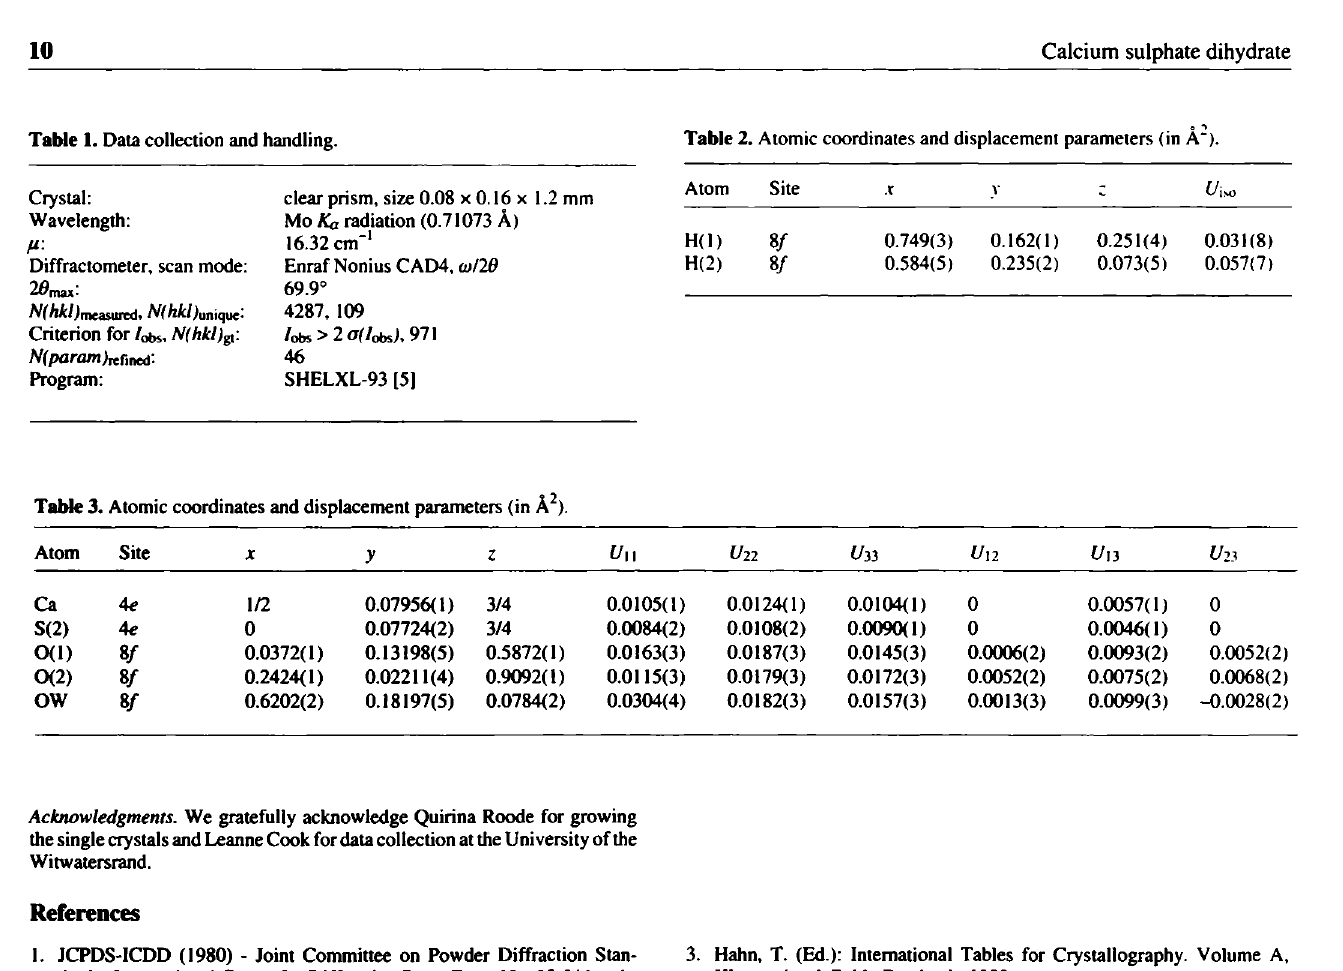
Table 1. Data collection and handling. Table 2. Atomic coordinates and displacement parameters (in Â").